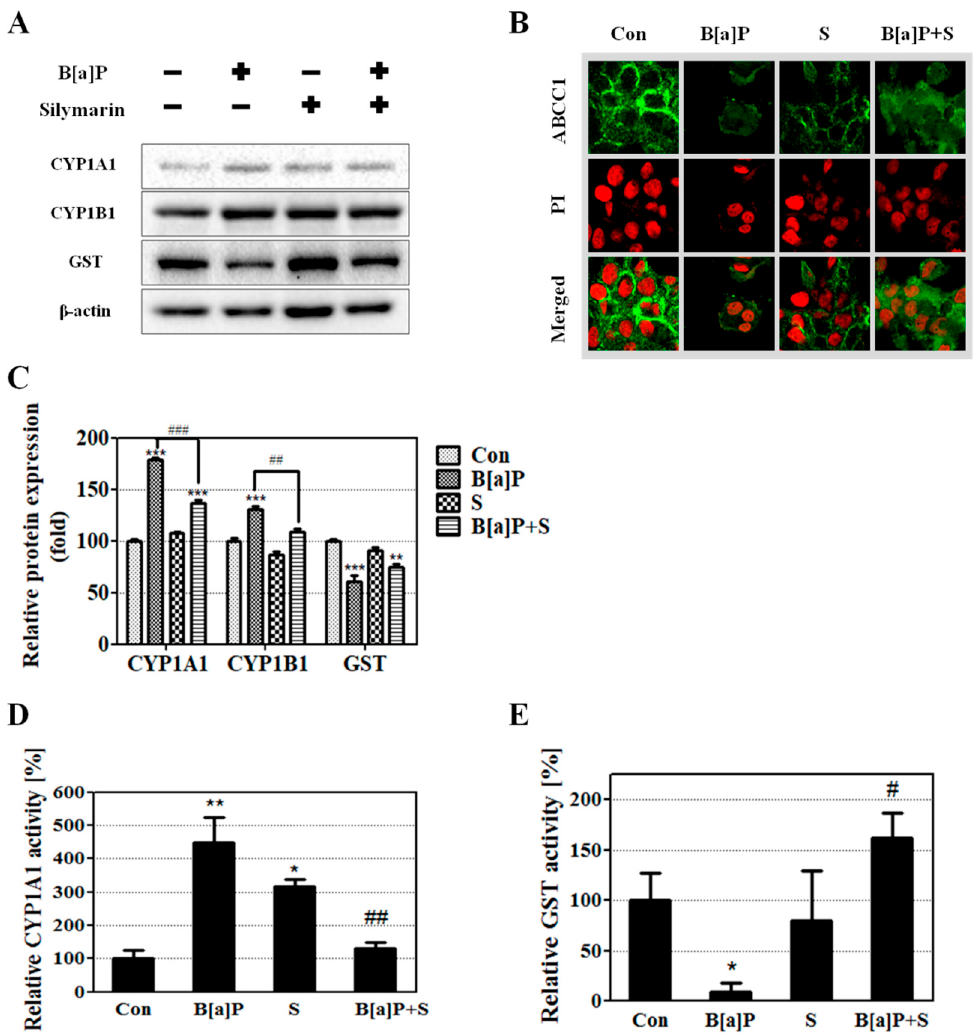
Figure 3. Expression of phase I, II, and III enzymes was induced by incubation for 48 h with B[a]P (10 µ M) and co-treatment with silymarin (40 µ M). ( A ) Cell lysates were prepared and the level of detoxifying enzymes was measured by Western blot; ( B ) The expression of multidrug resistance-associated protein 1 (ABCC1) was measured using immunocytochemistry. ( C ) Quantitative protein expression was calculated. ( D , E ) cellular cytochrome P450 (CYP)1A1 and glutathione S-transferase (GST) were activated and the relative levels of activation were calculated. All values are expressed as mean ± standard error of mean (SEM) ( n = 3). The relative activation levels of CYP1A1 and GST were significantly di ff erent compared to those of the controls (* p < 0.05, ** p < 0.01, *** p < 0.001) and B[a]P (# p < 0.05, ## p < 0.01, ### p < 0.001) in Tukey’s multiple comparison test.